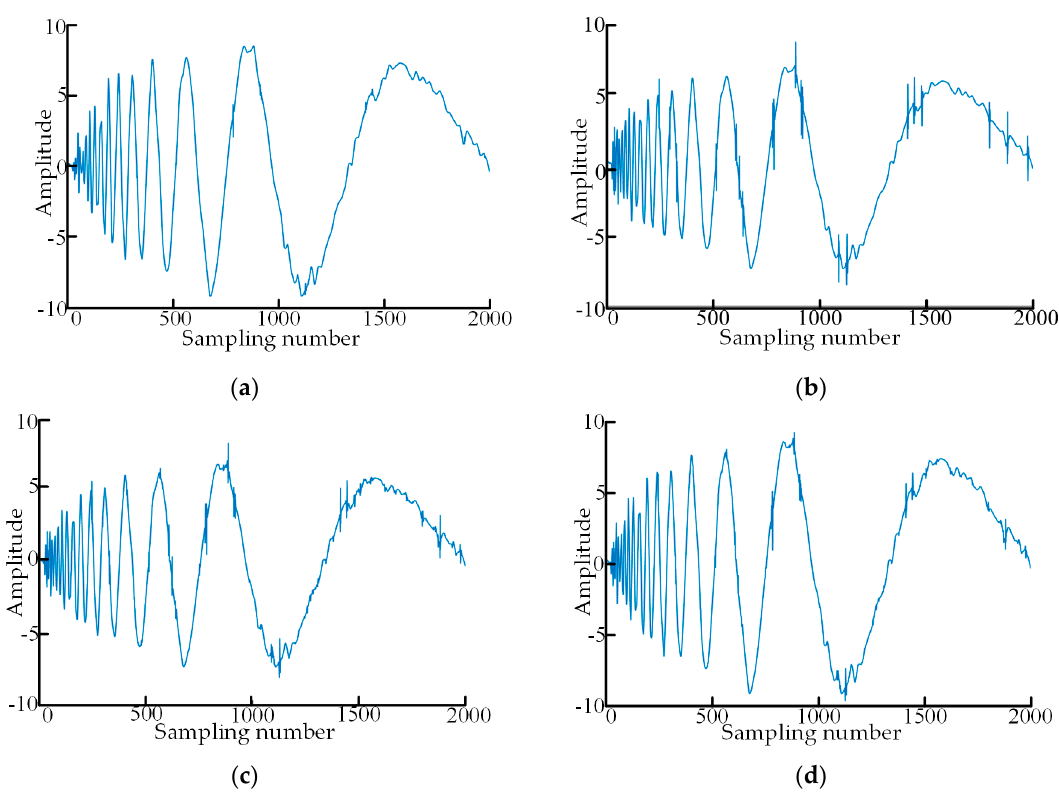
Figure 5. The comparison of noise reduction results in simulation. ( a ) Data after noise reduction by soft threshold function; ( b ) data after noise reduction by hard threshold function; ( c ) data after noise reduction in reference [29] function; ( d ) data after noise reduction by new threshold function.